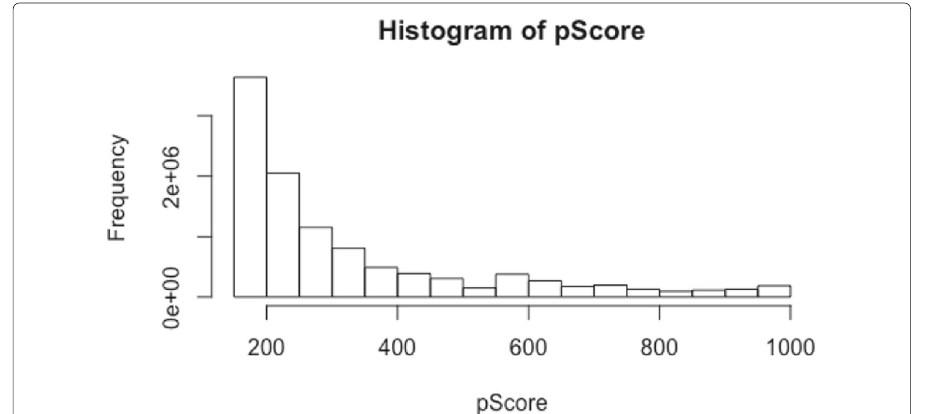
Fig. 9 The distribution of the combined score extracted from the open STRING data base